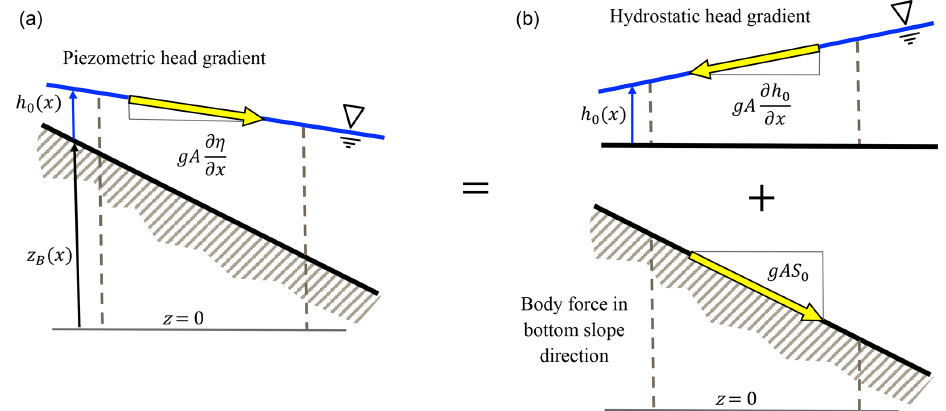
Figure 1. The η form of the SVEs (a) has a driving Piezometric head gradient which is equivalent (b) to the sum of the hydrostatic head gradient and a body force aligned with S 0 . The effect of varying geometry is handled in A in both forms.